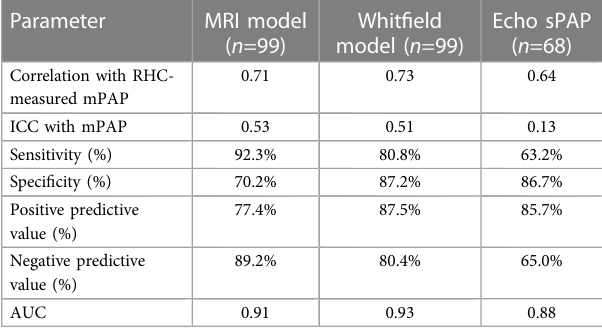
(Supplementary Table 1). Pearson Chi-Square value for the test was 16.29 and Fisher ’ s exact test value was